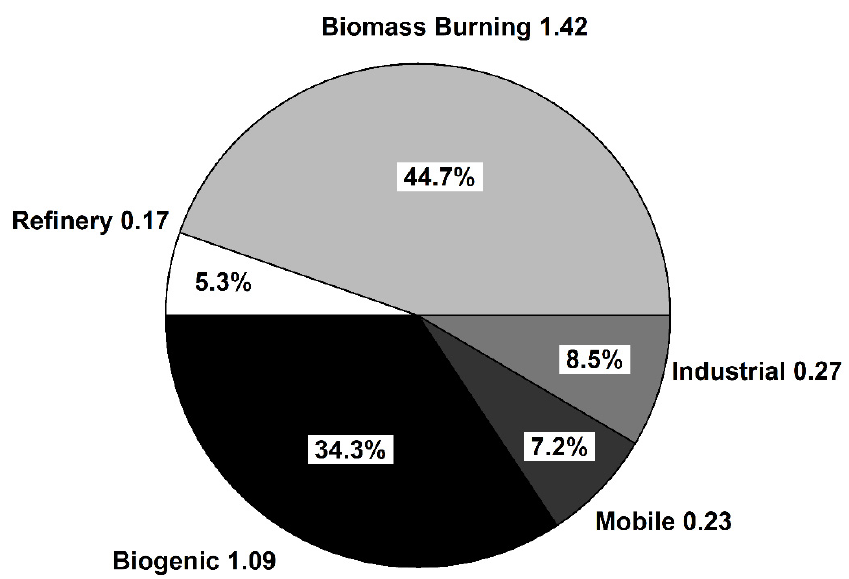
represent the average absolute concentration (ppbv) of HCHO attributed to each Figure 4. PMF estimated source contributions during 2004–2015. Values outside the pie chart rep- resent the average absolute concentration (ppbv) of HCHO attributed to each factor.